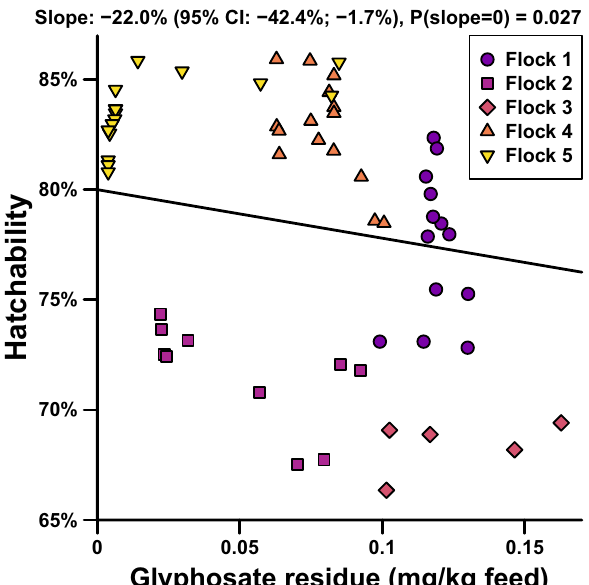
Figure 1. Linear mixed effects model of hatchability. Hatchability as a function of feed residues of glyphosate with adjustment for breeder age, storage times on farm until delivery and storage times at hatchery until incubation